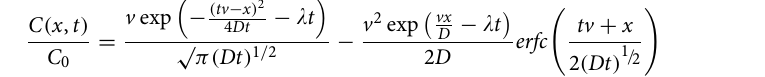
the radioactive decay was corrected by using the decay constant λ = 0.023 year −1 . The estimated results are shown in Fig. 5a,b for D 2 O and Fig. 6a,b for 137 Cs. We estimated both tracer radial migration from the surface to the center of wood using the single diffusion coefficients measured separately for D 2 O and 137 Cs in sapwood and showed in Figs. 5a and 6a. On the other hand, in Figs. 5b and 6b, we used the same diffusion coefficients measured in sapwood for tracers D 2 O and 137 Cs migration from sapwood to the center of intermediate wood and afterwards changed the smallest diffusion coefficients of D 2 O and 137 Cs measured in heartwood for the tracers migrating analyses from the center of intermediate wood to the center of wood in heartwood. Comparison between panels (a) and (b) in both figures indicates characteristics that the tracer (D 2 O and 137 Cs) concentrations in heartwood changed irregularly at the boundary of the intermediate wood zone. The highly discontinuous changes in 137 Cs concentration were strongly dependent on differences in the